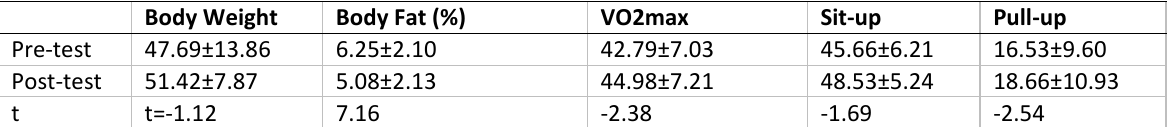
Table 2. Body composition, aerobic capacity and muscular endurance of the subjects before and after four- week preparation Body Weight Body Fat (%) VO2max Sit-up Pull-up